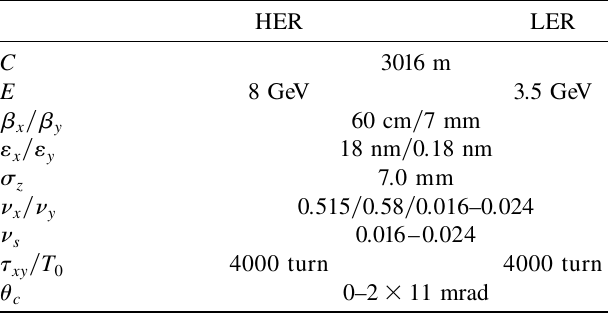
TABLE I. Basic parameters of KEKB.